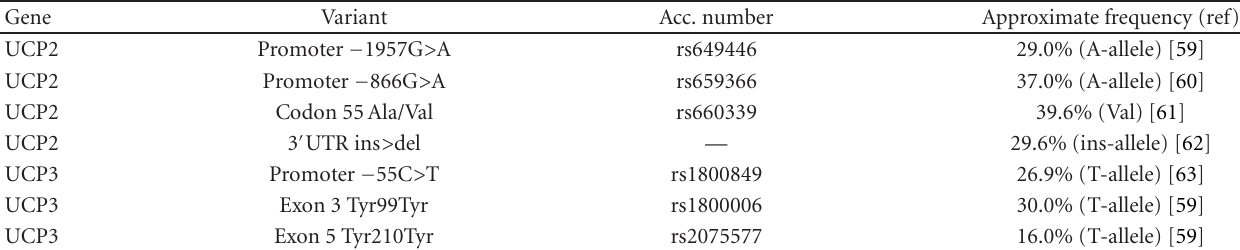
Table 1: Studied high frequency variants of the UCP2 and UCP3